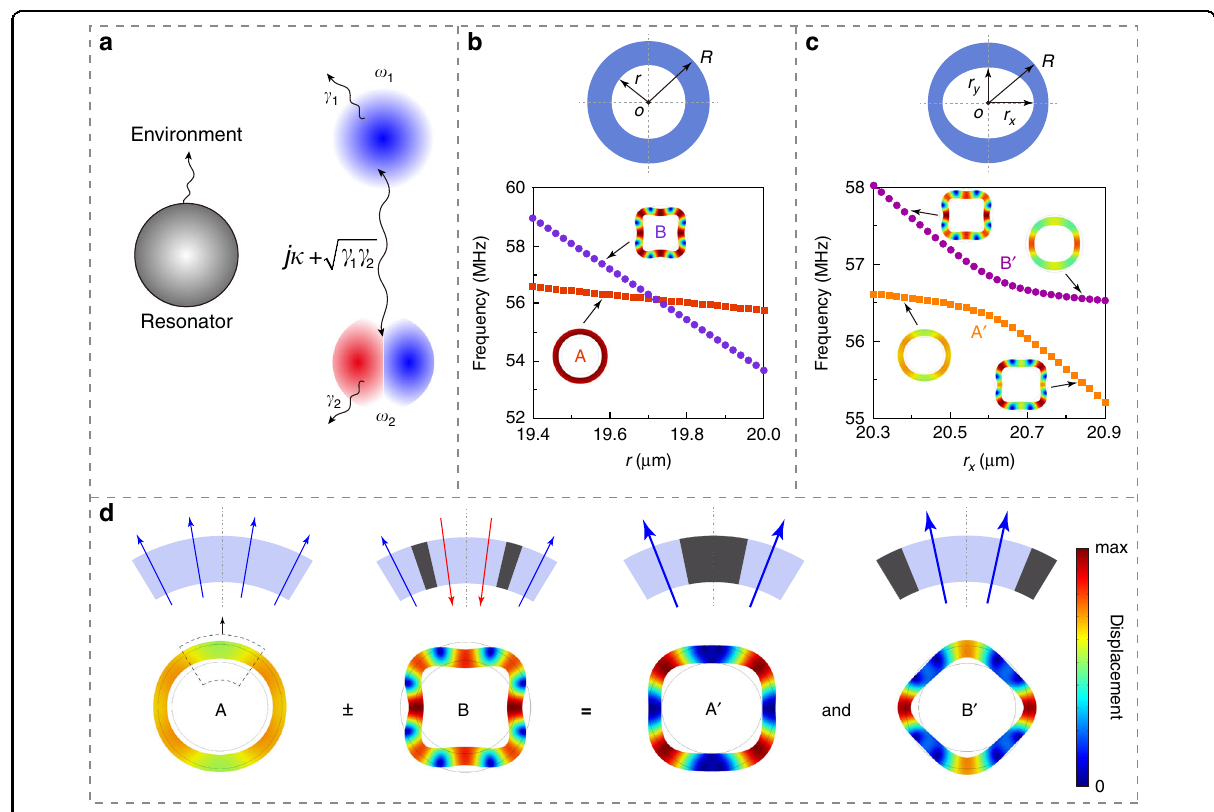
Fig. 1 Construction of mechanical BIC in a micromechanical resonator based on modal coupling. a Schematic of dispersive and dissipative coupling between two eigenmodes of a resonating system. b Simulated frequencies of mode A (dark red rectangles) and mode B (violet dots) of a ring-shaped silicon micromechanical resonator with azimuthal symmetry as a function of the inner radius r . The resonator has a thickness h = 220 nm and outer radius R = 26.1 μ m. Modes A and B are the fundamental radial-contour mode and the 4th-order wine-glass mode, respectively. c Simulated frequencies of mode A ’ (orange rectangles) and mode B' (purple dots) of a ring-shaped resonator with broken azimuthal symmetry as a function of semi-major axis of the inner boundary r x . The resonator has a thickness h = 220 nm, outer radius R = 26.1 μ m, and semi-minor axis of the inner boundary r y = 18.7 μ m. d Generation of the hybrid modes A ’ and B ’ from coupling of the original modes A and B at the anticrossing